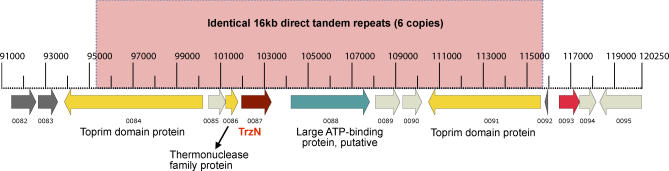
Organization of the Region of the A. aurescens pTC1 Plasmid Containing Six Identical Direct Tandem Repeats of Approximately 16 kb in LengthFor clarity, the locus tag (AAur_pTC1) was removed from the ORF numbers (for example, ORF number 0082 is AAur_pTC10082).